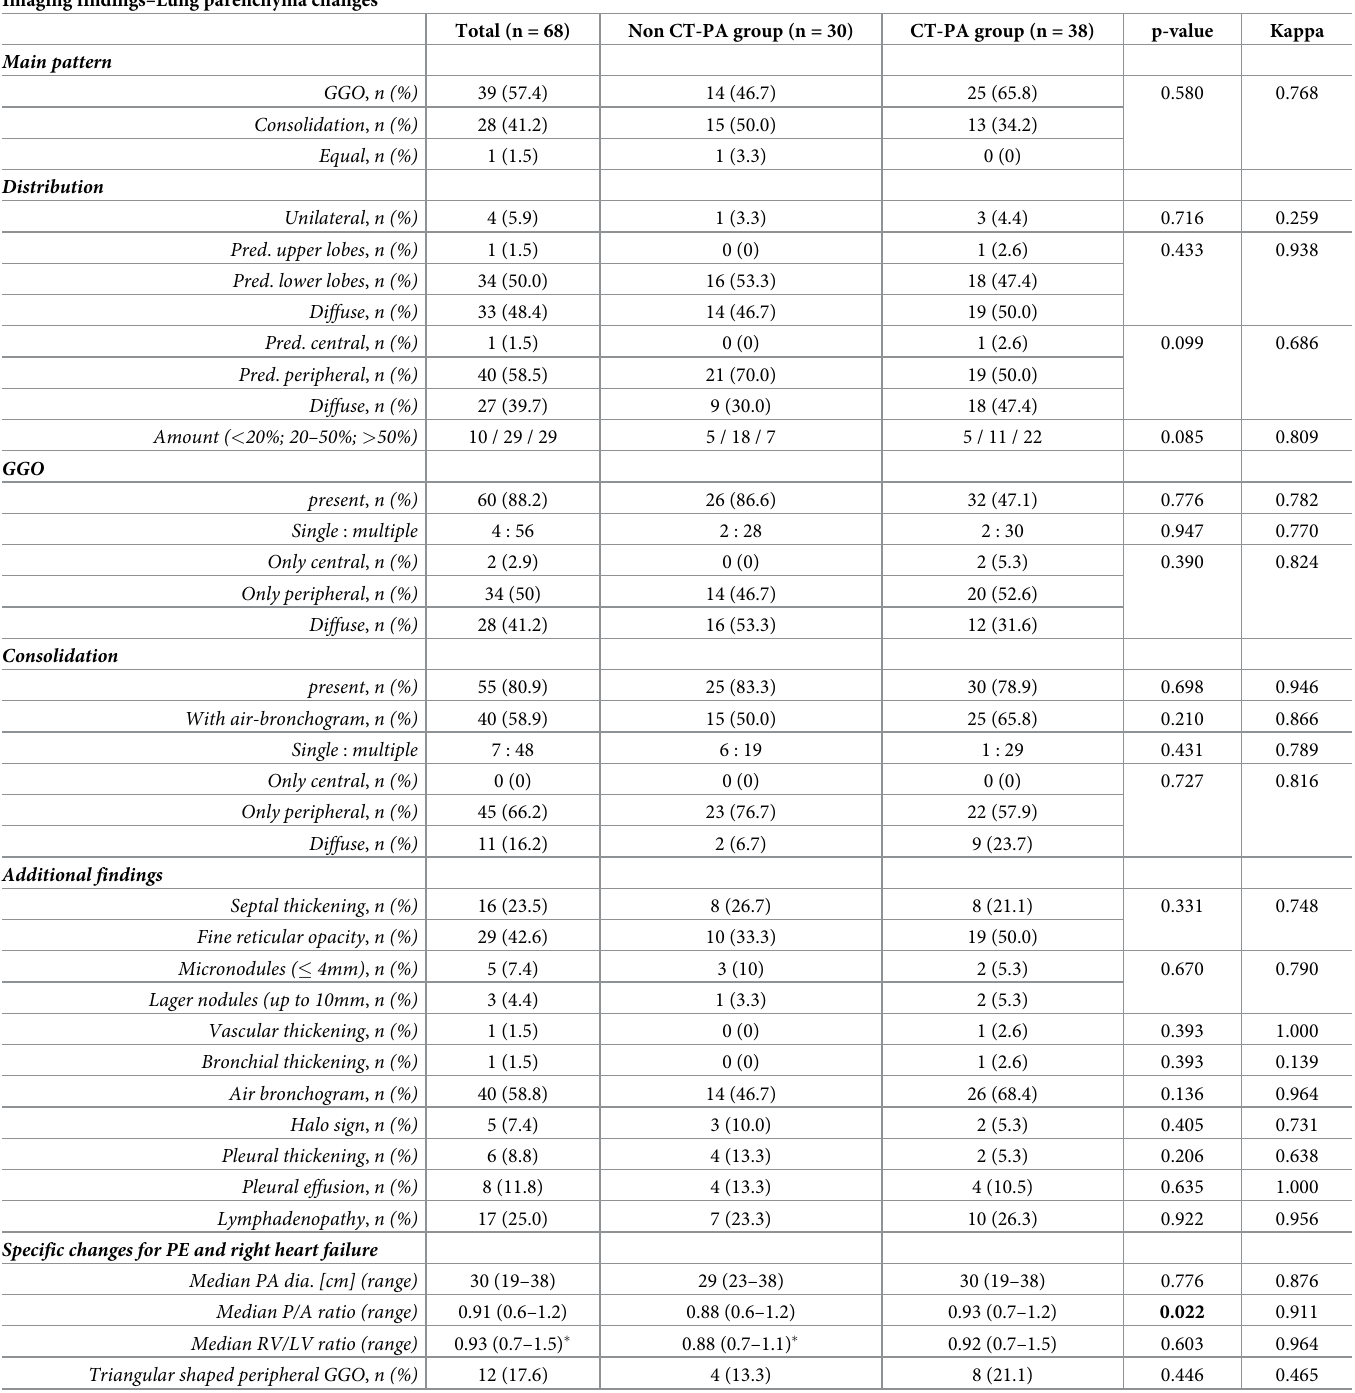
Table 1. Imaging findings in the COVID-19-cohort–Lung parenchyma changes. Computed tomography pulmonary angiography (CT-PA), Number of cases (n), Pre- dominant (Pred.), Ground-glass opacification (GGO), Cryptogenic organizing pneumonia (COP), bronchocentric pattern: conspicuous cuffs around larger bundles with extension to lung periphery, band like pattern: thick radial bands ( � 8mm width), sometime containing a small air bronchogram, which distinguishes it from linear atelec- tasis, crazy paving: GGO and superimposed interlobular septal thickening, pulmonary artery (PA), diameter (dia.), pulmonary artery aorta ratio (P/A ratio), right/left ven- tricular ratio (RV/LV